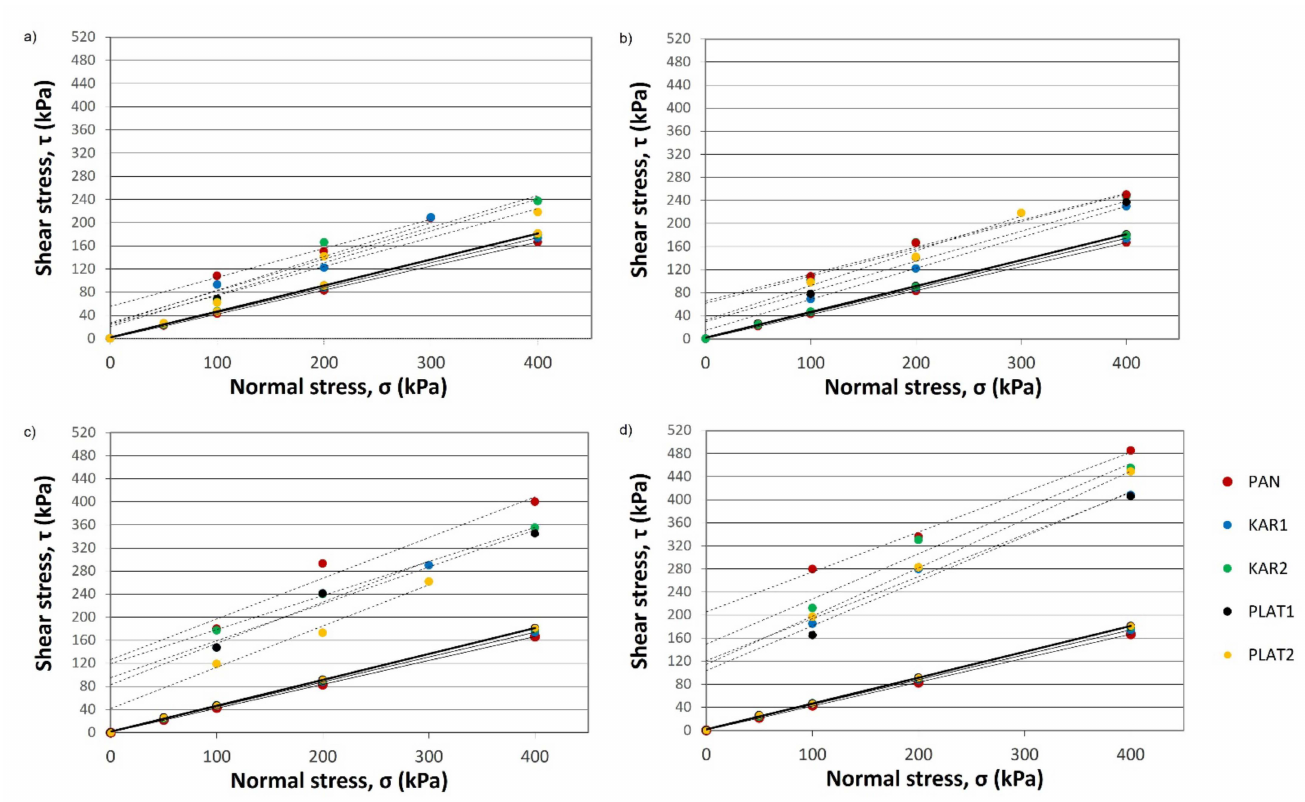
Figure 9. Large shear (dashed lines) and ring shear (solid lines) failure envelops the flysch specimens in ( a ) loose saturated, ( b ) dense saturated, ( c ) dense partially saturated, and ( d ) dense optimum